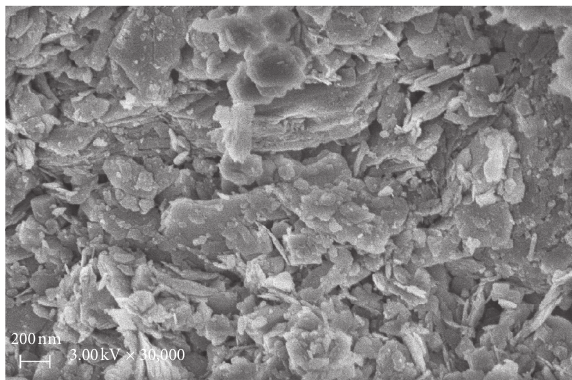
Figure 5: SEM image of 15% calcium carbonate-doped red clay.